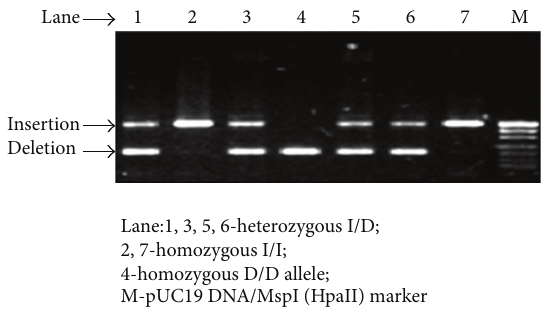
Figure 1: Representative band patterns of ACE I/D polymorphism analyzed using agarose gel electrophoresis. Table 1: The demographic characteristics and ACE I/D genotype distributions of the study